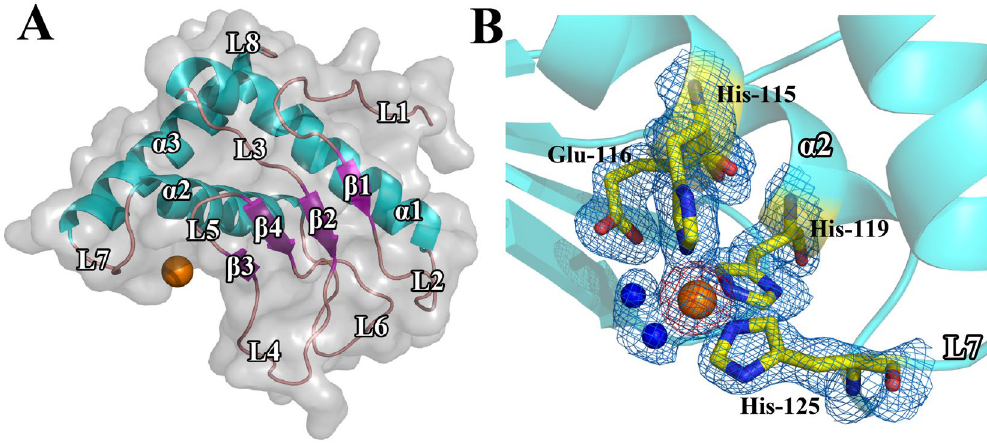
Figure 1. The crystal structure of ScWss1 21-148 (PDB: 5XBN). ( A ) The overall structure of ScWss1 21-148 with secondary structure elements labeled. The helices are shown in cyan, sheets in purple, loops in salmon and zinc ion in orange. The molecular surface of the domain is shown in transparent gray. ( B ) Close-up view of the active site, composed of His-115, His-119, His-125, and a zinc ion (orange sphere) in the center, accompanied by Glu- 116 as well as a water molecule (blue sphere) between the zinc ion and Glu-116. The 2F o -F c electron density map (blue) is contoured to 1 σ , whereas the F o -F c density map (red) for the Zinc ion is contoured to 3 σ .